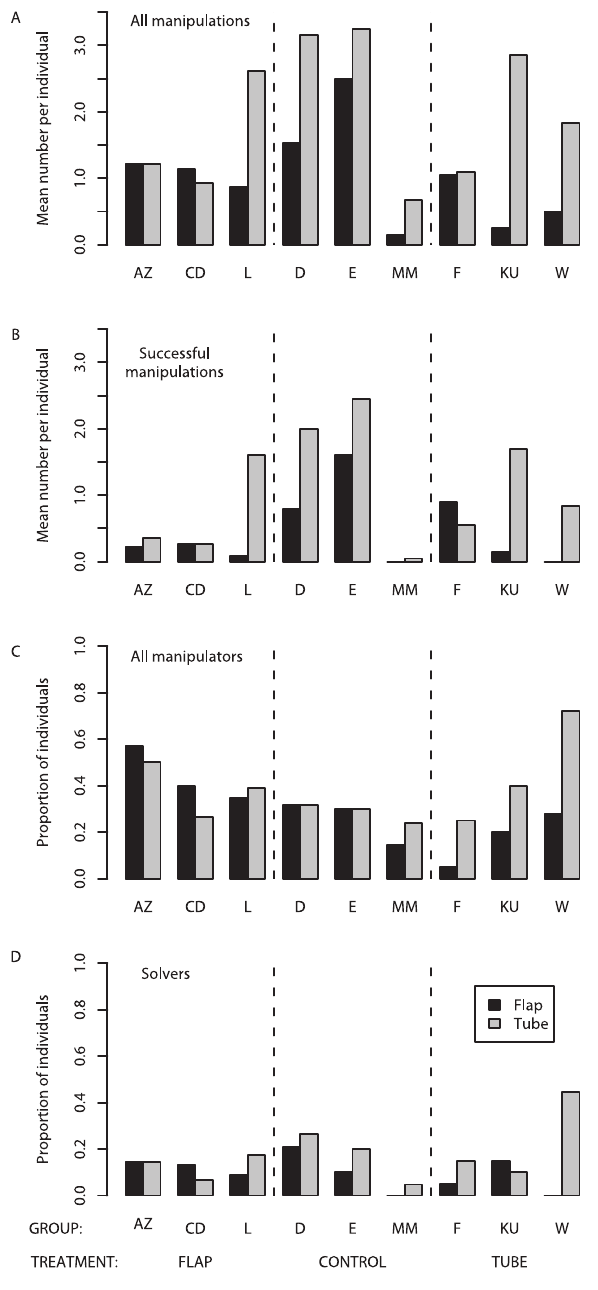
Figure 4. Group differences in manipulations of the flap and tube. A) The number of manipulations of the flap and tube; B) the number of successful manipulations of the flap and tube; C) the proportion of individuals that manipulated the flap and tube; and D) the proportion of individuals solving the task using the flap and tube. Trained demonstrators are not included in all cases. Letter codes refer to different groups.